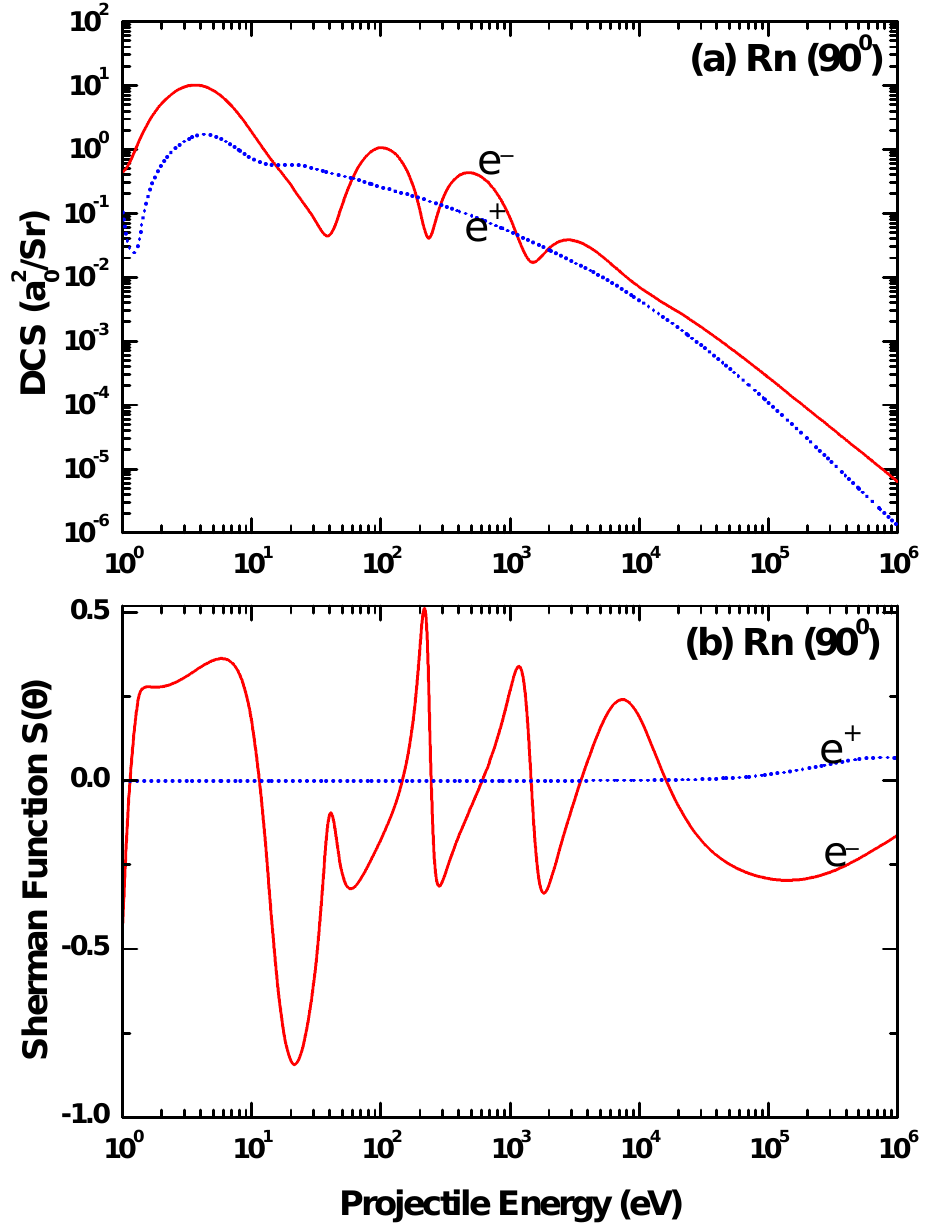
Figure 32. Comparison of ( a ) the differential cross section and ( b ) the corresponding Sherman function for the collisions of electrons and positrons from neutral radon targets at the scattering angle of 90 ◦